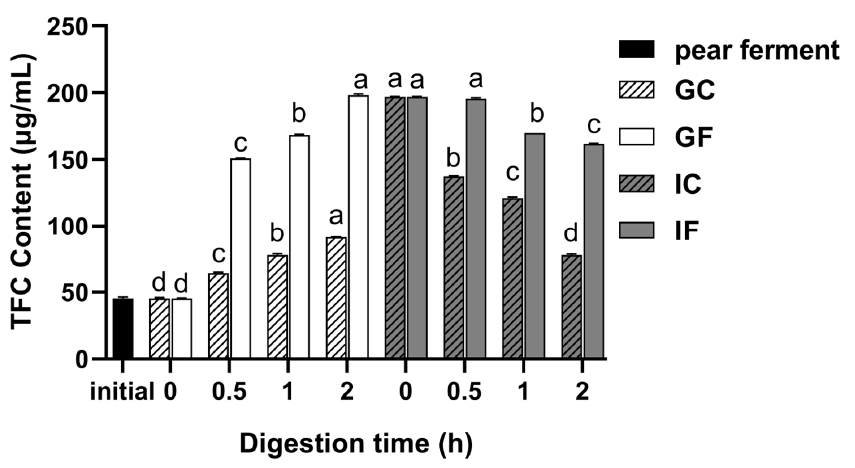
Figure 2. Changes of TFC of ‘Xuehua’ pear ferment during the simulated gastric and intestinal digestion in vitro. Different letters indicate significant differences in the same group under different digestion times ( p < 0.05). Data shown as means ± SD of three replicates ( n = 3).